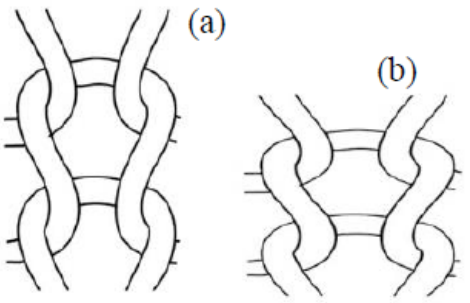
Figure 3. Loop changing presumption during stretching: ( a ) before stretching and ( b ) after stretching.